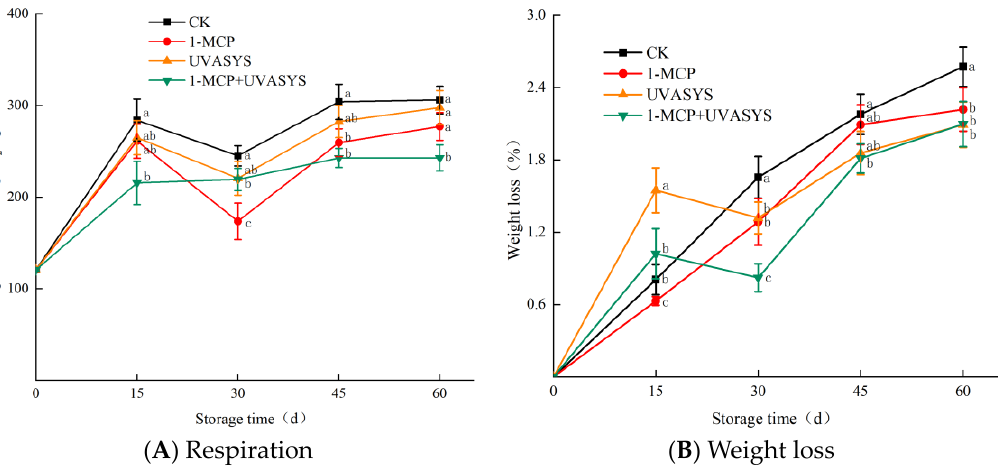
Figure 1. Effects of 1-MCP and UVASYS on respiration rate ( A ) and weight loss rate ( B ) of bamboo shoots during storage. Each data point represents an average ± standard error ( n = 3). Different letters indicate significant differences among treatments for each sampling time at p < 0.05.